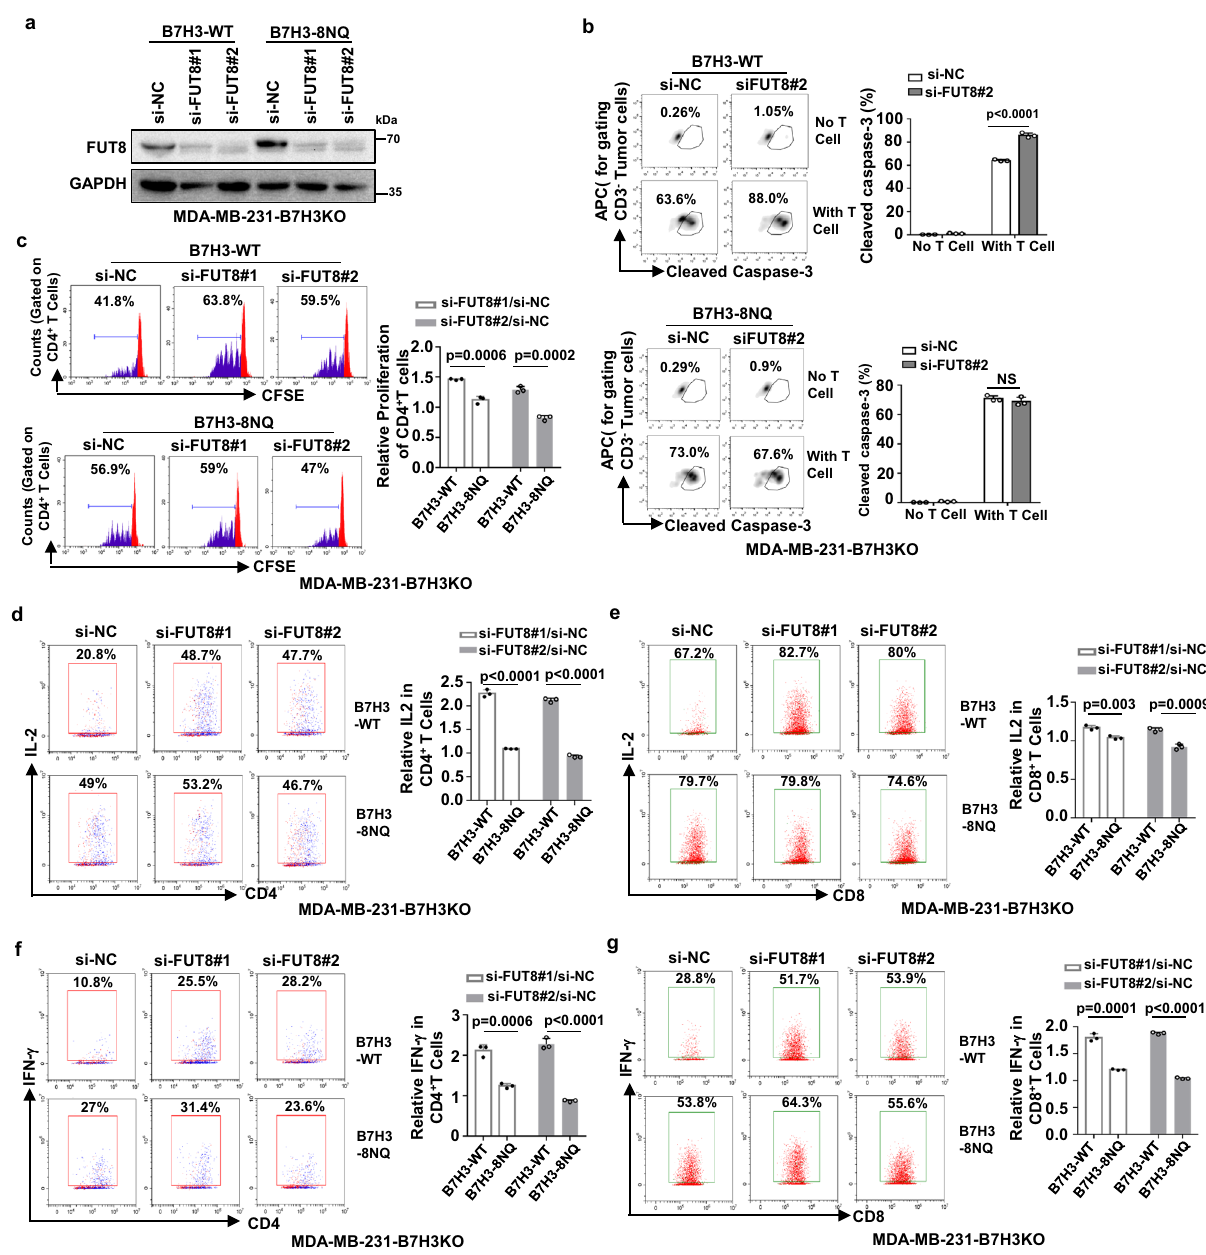
Fig. 6 Knockdown of FUT8 in TNBC cells enhances T-cell proliferation and activation. a The indicated MDA-MB-231-B7H3KO cells were transiently transfected with FUT8 siRNA for 48 h. The knockdown ef fi ciency was analyzed by immunoblotting. b The indicated MDA-MB-231-B7H3KO cells were transiently transfected with FUT8 siRNA for 48 h, then cocultured with CD3/CD28-activated human T-lymphocyte cells for another 6 h. Left: representative dot plots of the cleavage of caspase-3 in tumor cells measured by fl ow cytometry. Right: percentage of cleaved caspase-3 + tumor cells ( n = 3 biological independent samples). c – g Left: representative dot plots of in vitro activation of T measured by FACS as CFSE dilution after 5 days, respectively in the presence of irradiated B7H3-WT or B7H3-8NQ re-expressing in MDA-MB-231-B7H3KO cells. Right: percentage of proliferating CD4 + T ( c ), activation of IL2 + CD4 + T ( d ), IL2 + CD8 + T ( e ), IFN γ + CD4 + T ( f ), and IFN γ + CD8 + T ( g ) ( n = 3 biological independent samples). Error bars represent mean ± SD. The p value in b – g was determined by a two-tailed unpaired Student ’ s t test. NS, not signi fi cance. Data are representative of three independent